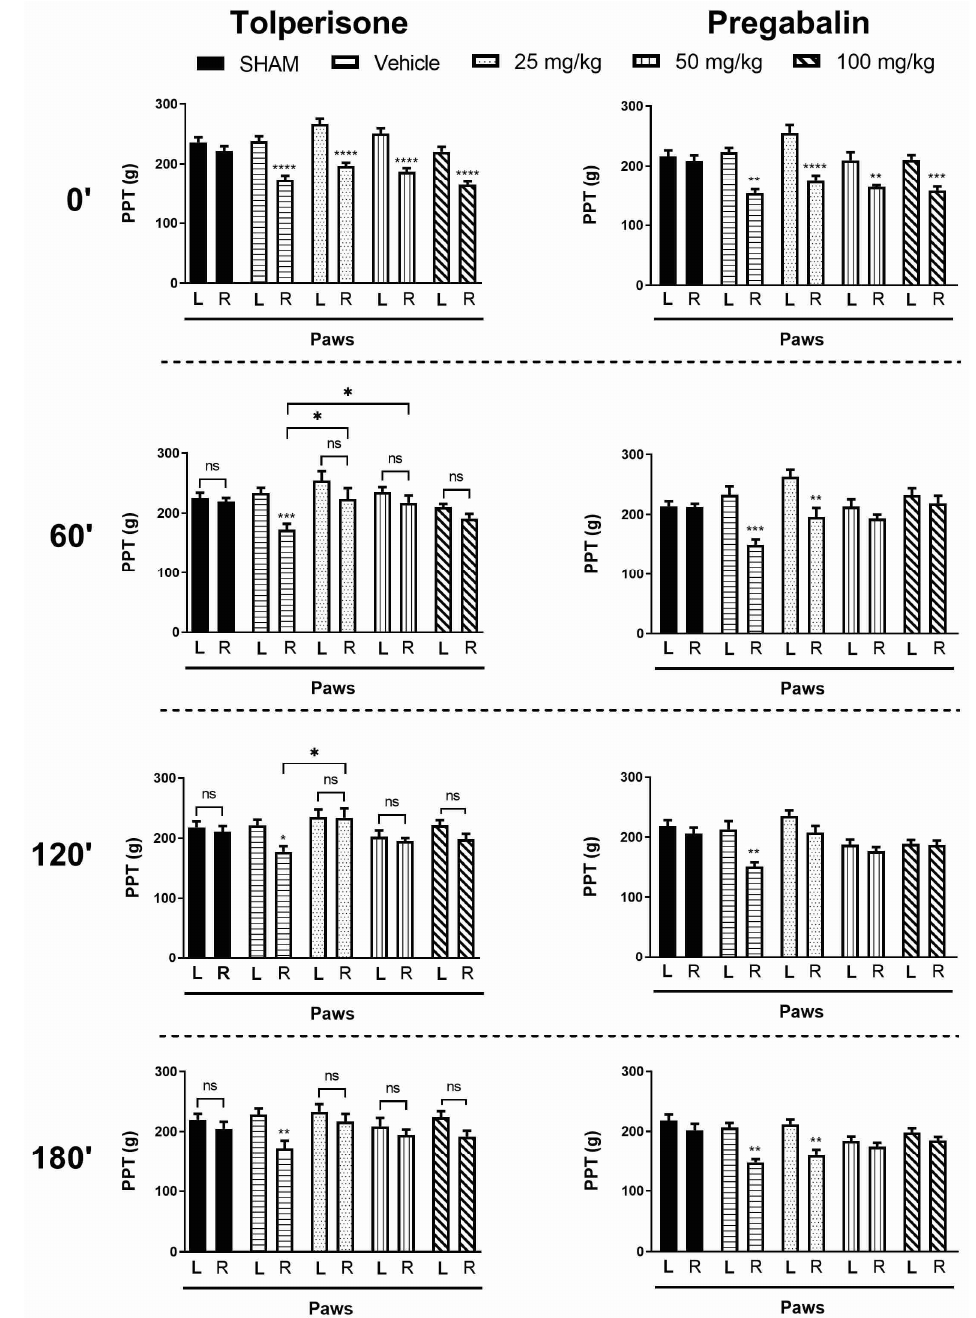
Figure 1. The antiallodynic effect of tolperisone ( left panels) and pregabalin ( right panels) following acute per os treatment (25, 50, 100 mg/kg). Graphs show the means of PPT ± S.E.M. in grams of animals’ left (healthy, L) and right (operated, R) paws before (baseline) and after treatment (60 min; 120 min; 180 min) with either tolperisone or pregabalin. Asterisks mark the significant differences compared to left (healthy) paws or vehicle treated group (one-way ANOVA, F(9, 104) = 16.17 (tolperisone 0 ′ ), F(9, 104) = 5.182 (tolperisone 60 ′ ), F(9, 92) = 3.354 (tolperisone 120 ′ ), F(9, 92) = 3.028 (tolperisone 180 ′ ), F(9, 82) = 11.15 (pregabalin 0 ′ ), F(9, 82) = 5.955 (pregabalin 60 ′ ), F(9, 82) = 5.464 (pregabalin 120 ′ ), F(9, 82) = 6.234 (pregabalin 180 ′ ), Newman–Keuls post-hoc test; ****: p < 0.0001; ***: p < 0.001; **: p < 0.01; *: p < 0.05; ns: non-significant). In each treatment group 6–16 animals were used.